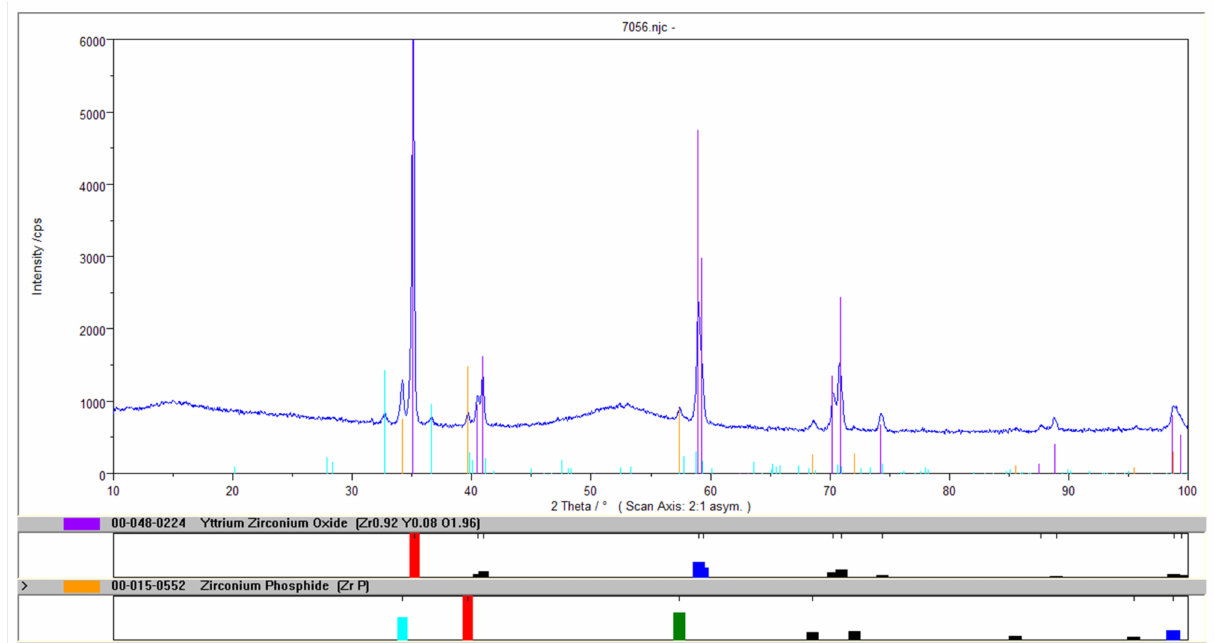
Figure 3. Diffractogram of the Ni–P–ZrO 2 composite powder. The surface morphology Ni–P–ZrO 2 showed that composite powder is a mixture of different types of grains (Figure 4). On the SEM microscopic image, one can observe grains of zirconium oxide coated with Ni–P amorphous alloy, grains without an alloy coating, clusters of Ni–P alloys and other inclusions, e.g., gadolinium. Figure 4c shows the grain of zirconium oxide during the formation of the amorphous nickel coating, and next Figure 4d (at higher magnification) shows the same grain completely covered with nickel coating.